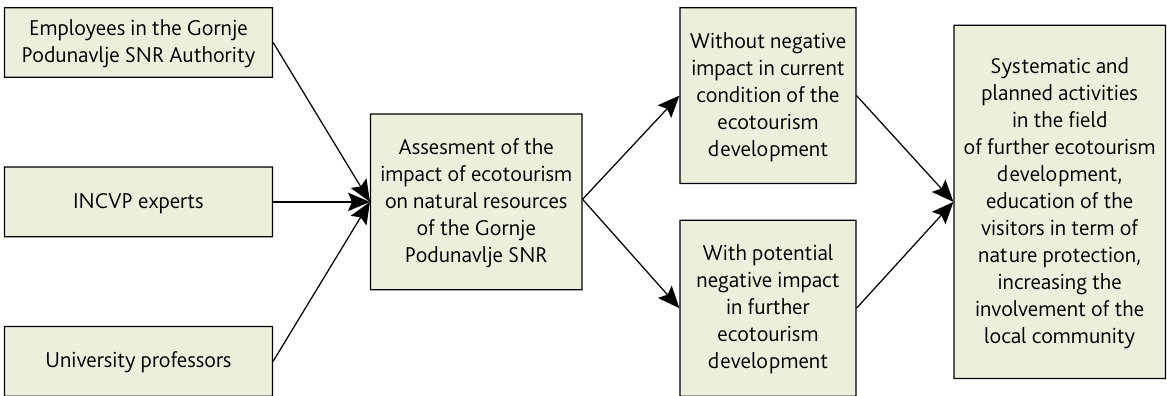
Figure 2. Key constructs in ecotourism development within the Gornje Podunavlje